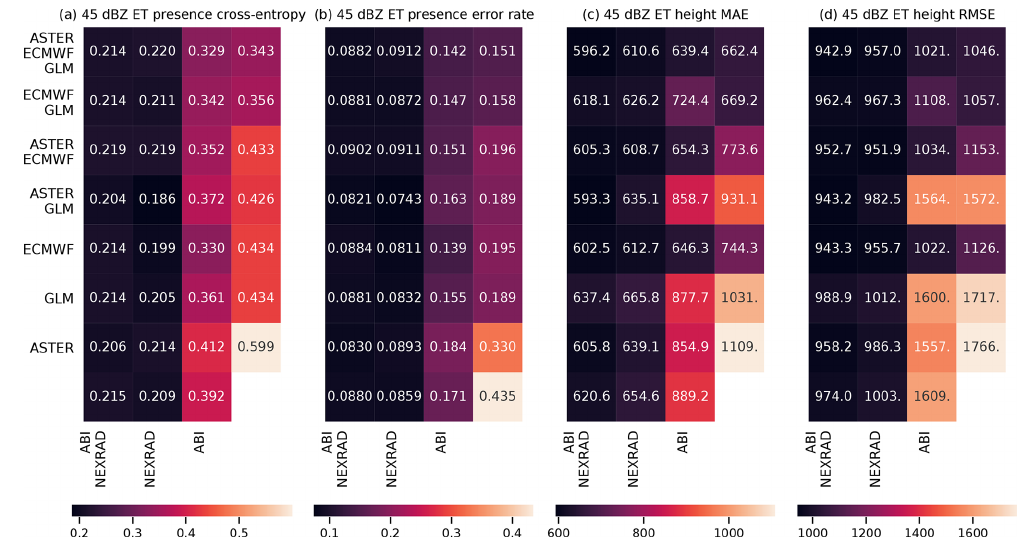
Figure A2. As Fig. 9, but for the training